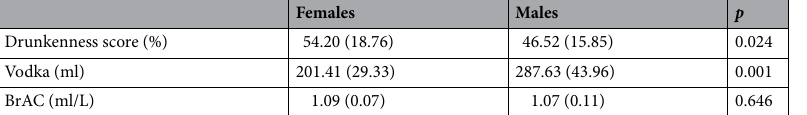
Table 2. Characteristics of alcohol intoxication. n Female = 50, n Male = 50, descriptive data are presented as mean and standard